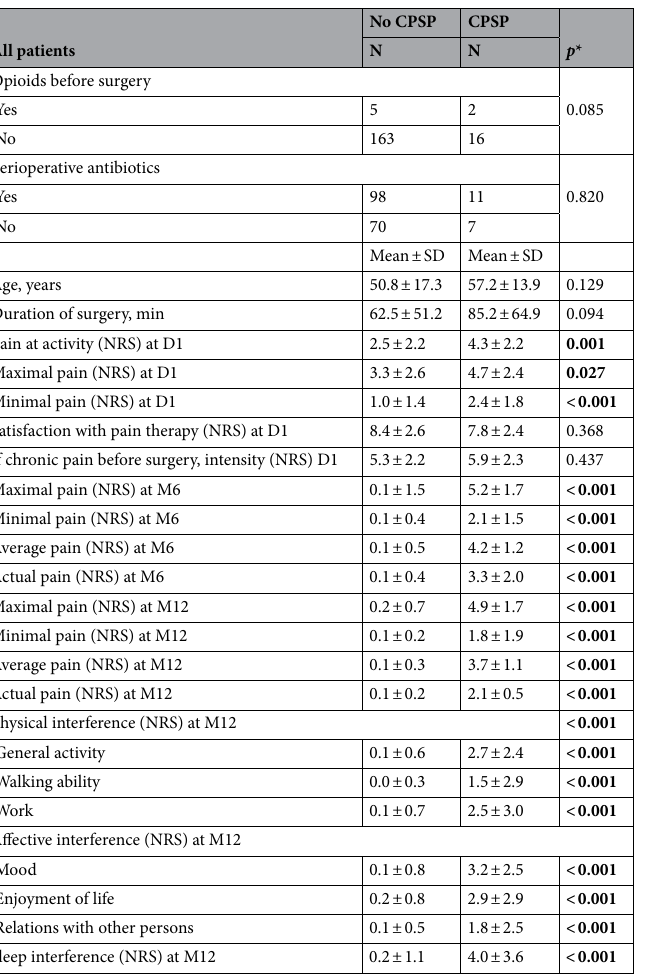
Table 2. Comparison of the characteristics of patients without chronic postsurgical pain (CPSP) or with CPSP 12 months (M12) after otorhinolaryngological (ORL) surgery. NRS = numeric rating scale. *Pearson’s chi-square test or Fisher’s exact test was used to compare ordinal and nominal data of patients without CPSP and with CPSP. The nonparametric Mann–Whitney-U-test was used to compare metric data. Bold values are statistically significant for p <